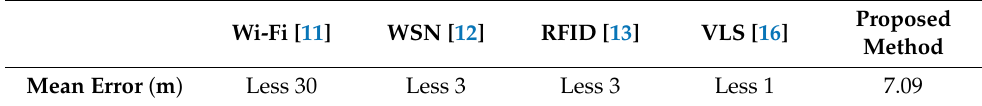
Table 3. Performance comparison with other